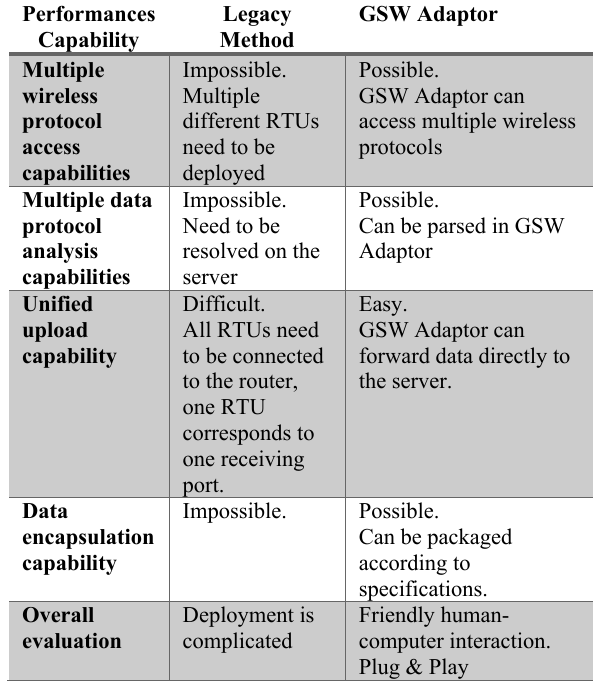
Table 2. Advantages of GSW